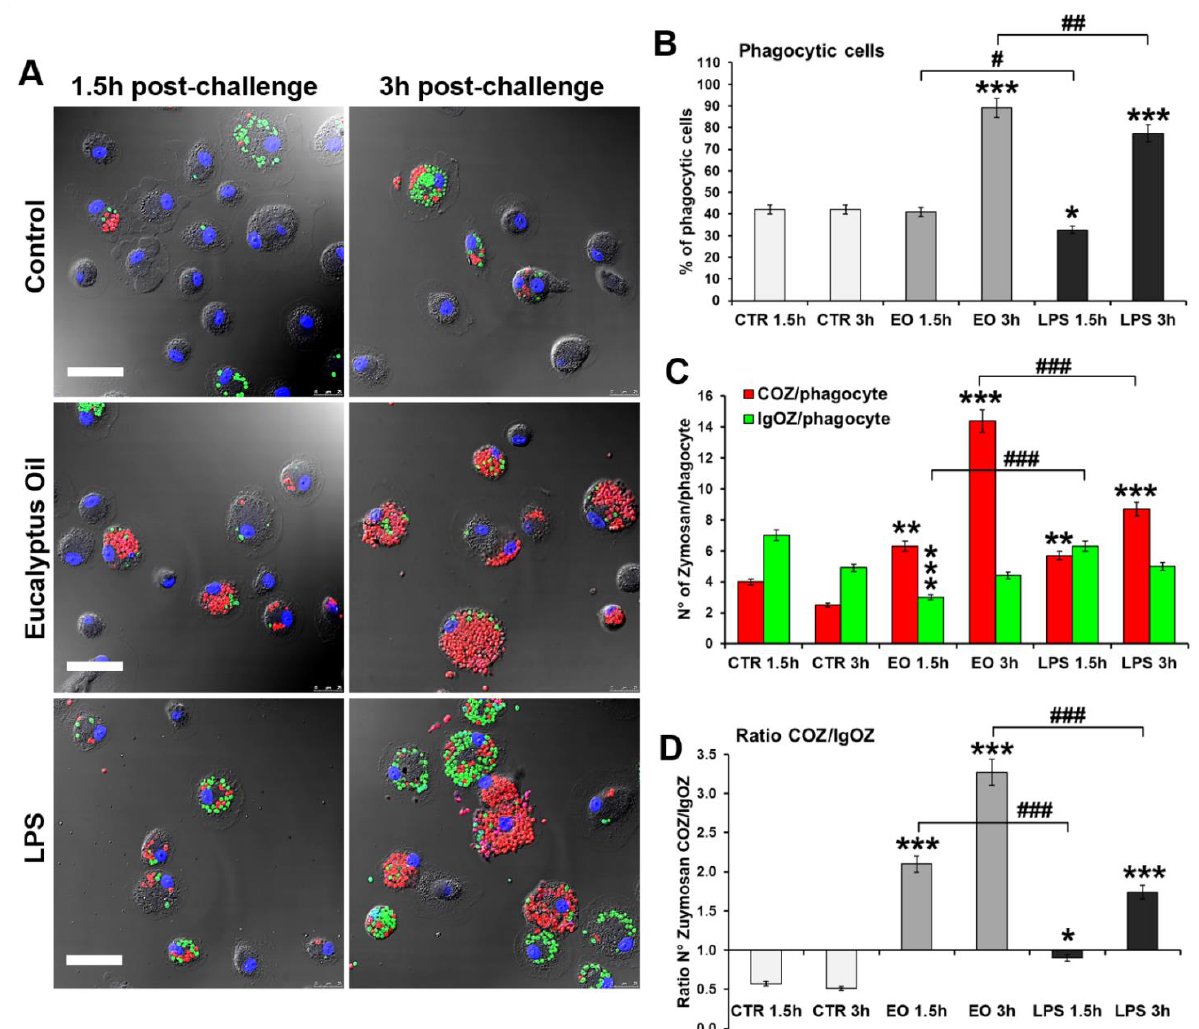
Figure 5. Complement receptor involvement in EO-stimulated phagocytosis. ( A ) Representative images by confocal microscopy of MDM cultures 1.5 h and 3 h after addition of fluorescent COZ or IgOZ to the culture medium. Alexa Fluor 594-COZ (red hue) and Alexa Fluor 488-IgOZ (green hue) were simultaneously added (20 total yeasts/cell, ratio COZ/IgOZ 1:1) to MDMs pre-treated 24 h with 0.008% EO or 6 h with 0.1 µg/mL LPS. Cell nuclei were counterstained with 0.2% Hoechst. Merged images with differential interference contrast, used to visualize cell morphology, are shown. Bars = 50 μm. ( B – D ) Quantitative analysis of the phagocytosis assay: results were obtained by counting the number of phagocytes, reported as percent of phagocytic cells ( B ) as well as the number of red COZ or green IgOZ per phagocytic cell ( C ), also expressed as ratio COZ (n)/IgOZ (n), for which values >1 indicate that COZ particles are internalized at higher numbers than the IgOZ particles. A minimum of 200 cells/sample were analyzed and the results are the mean ± SD from three independent experiments ( n = 3). Significance (One-way ANOVA + Tukey multiple comparison test); * significance vs. CTR at the same time: * p < 0.05, ** p < 0.01, *** p < 0.001; # significance vs. LPS at the same time: # p < 0.05, ## p < 0.01, ### p < 0.001.